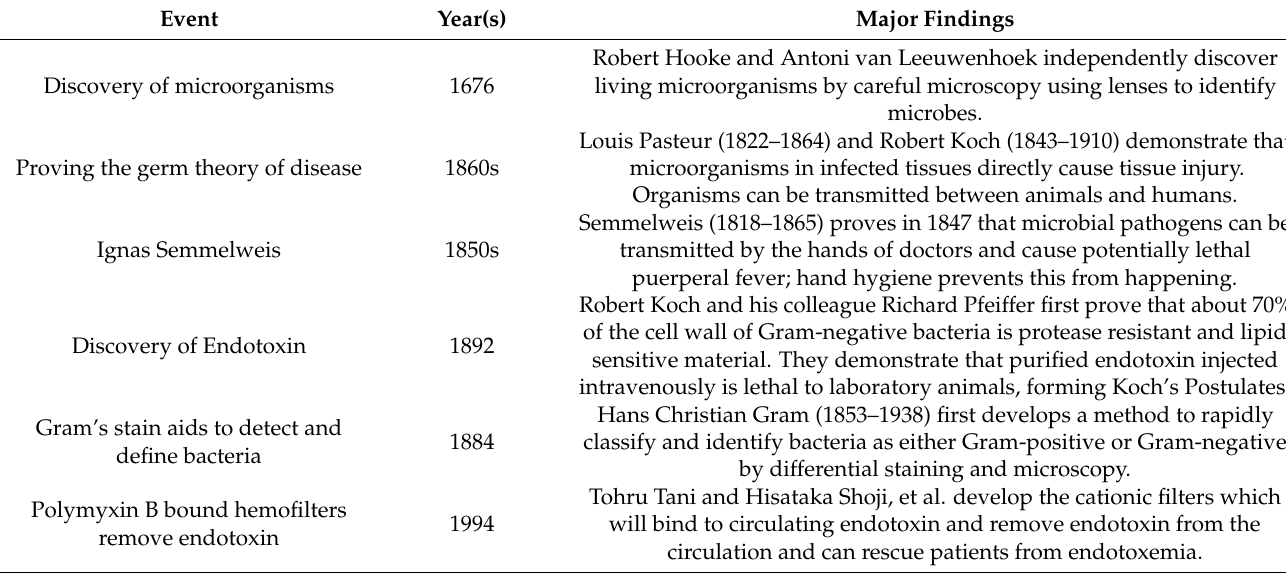
Table 1. Historical